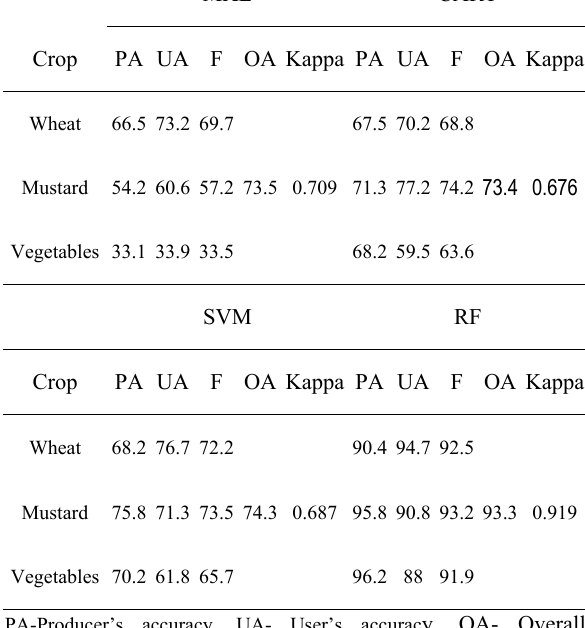
Figure 9. Crop area obtained by classifying Sentinel-2 imagery using different